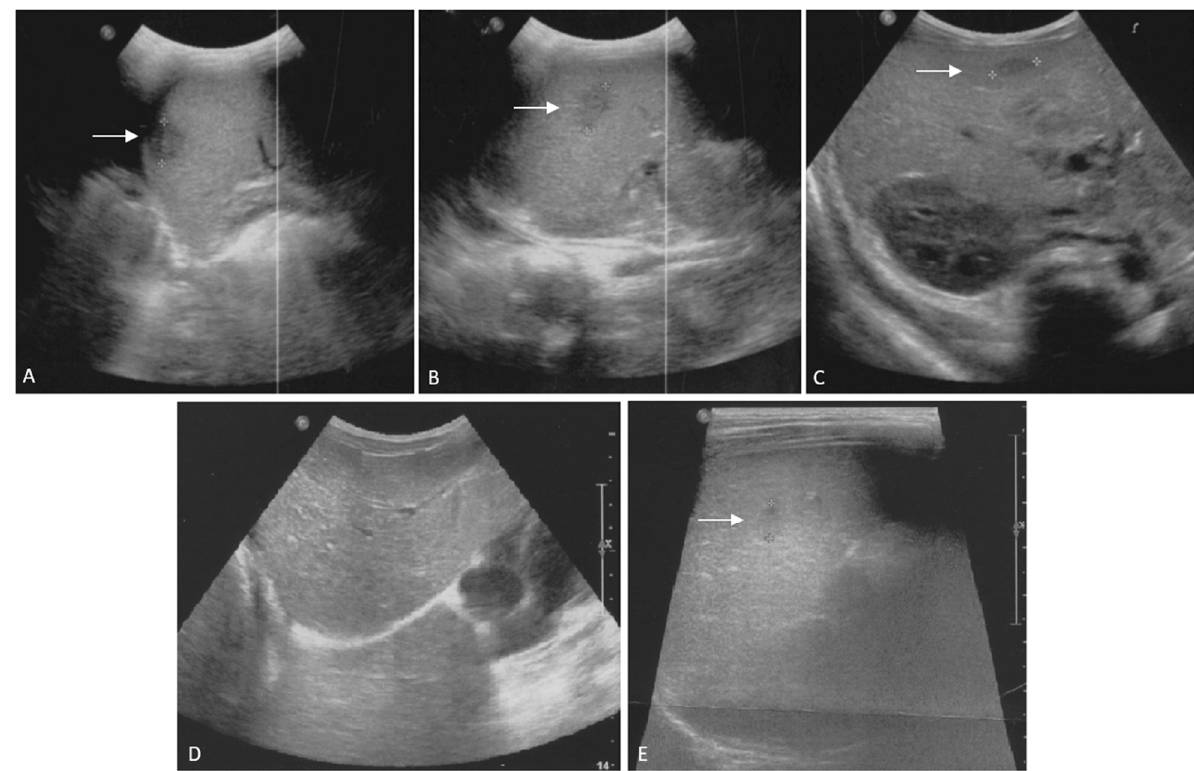
protein; PCT, procalcitonin.